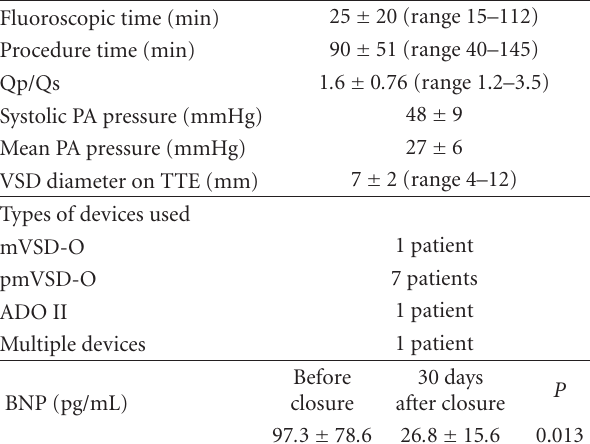
Table 2: Summary of procedure data.